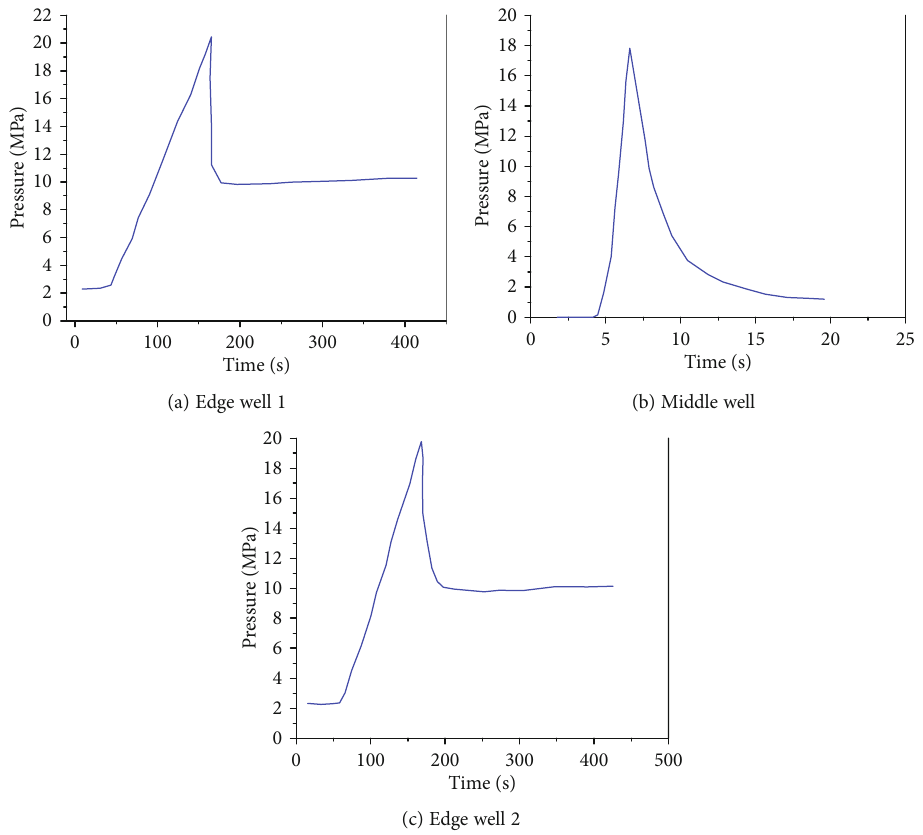
Figure 4: Pressure versus time from multiple fracturing of sample 2.